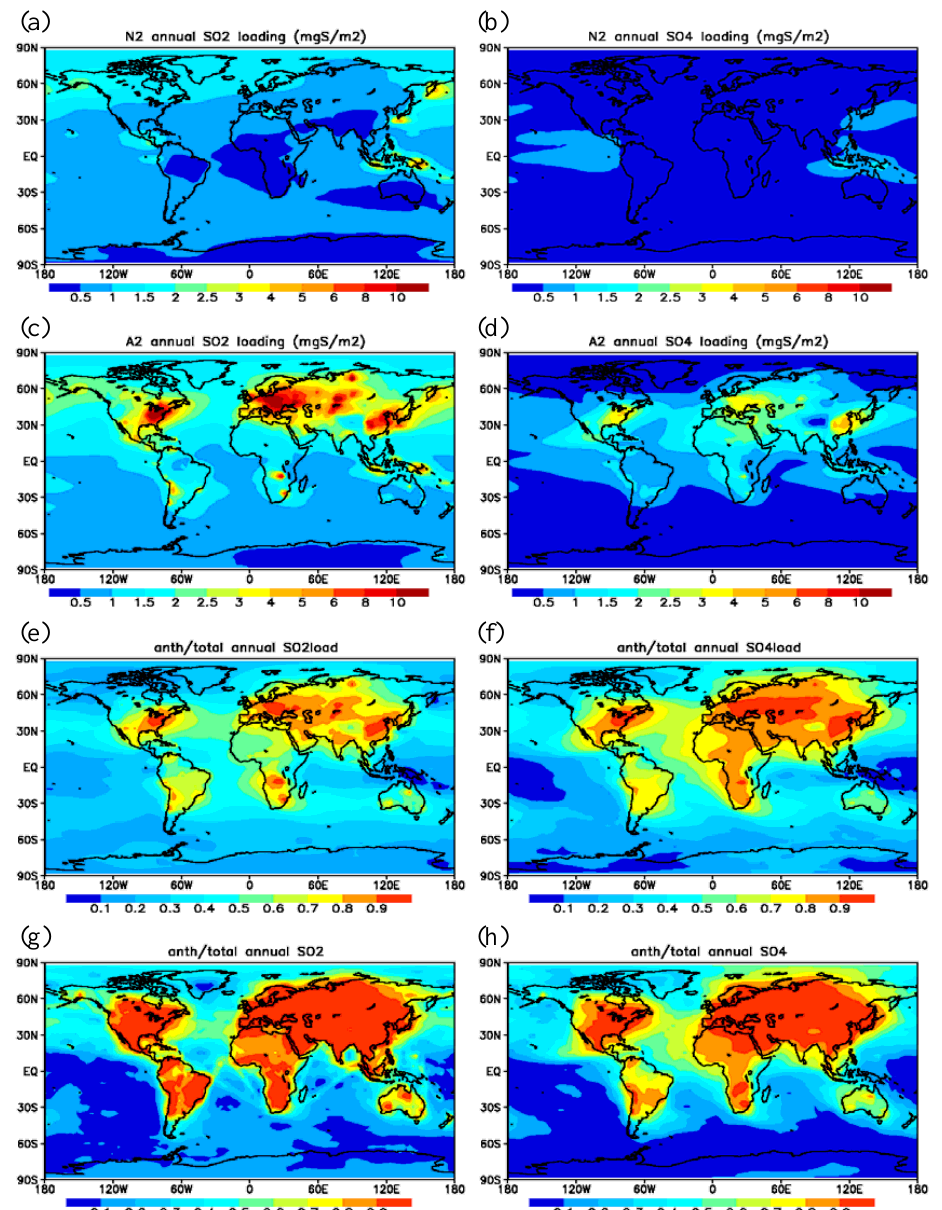
Fig. 3. Comparison of the global distribution of SO 2 (left) and sulfate (right) from GCCM simulations. Top row: column loading (in mgS m − 2 ) from the N2 simulation; Second row: column loading (in mgS m − 2 ) from the A2 simulation; Third row: ratio of anthropogenic to total (A2–N2:A2) column loading; Bottom row: ratio of anthropogenic to total (A2–N2:A2) concentration near the